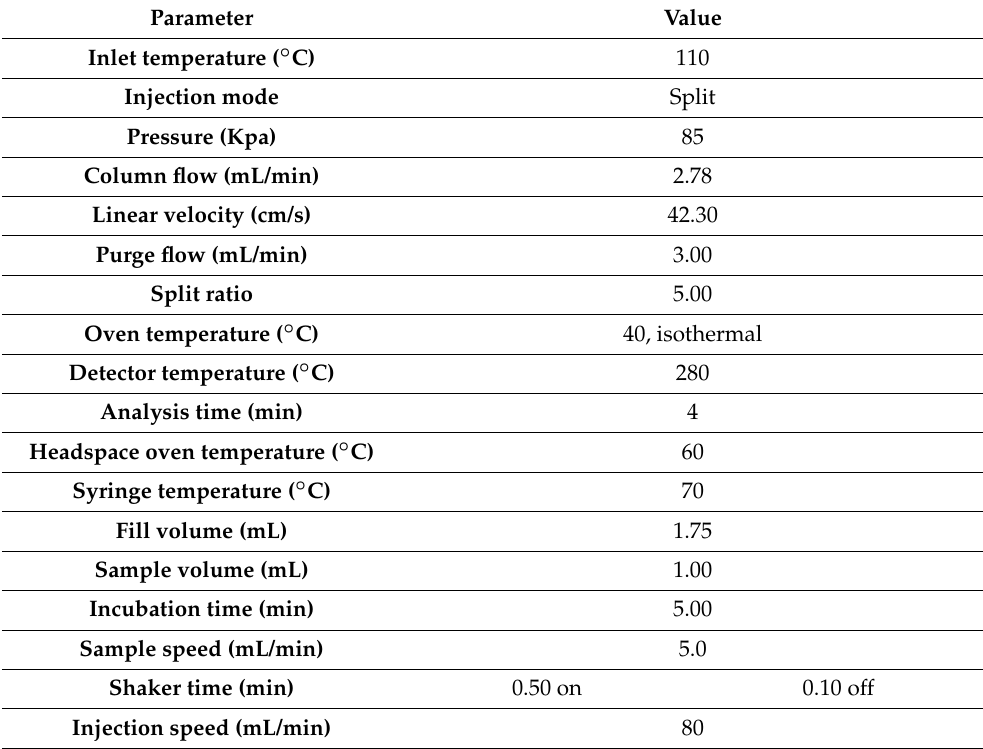
Table 3. Instrumentation Setup : GC-FID parameters for the dual-column detector system. Parameter Value Inlet temperature ( ◦